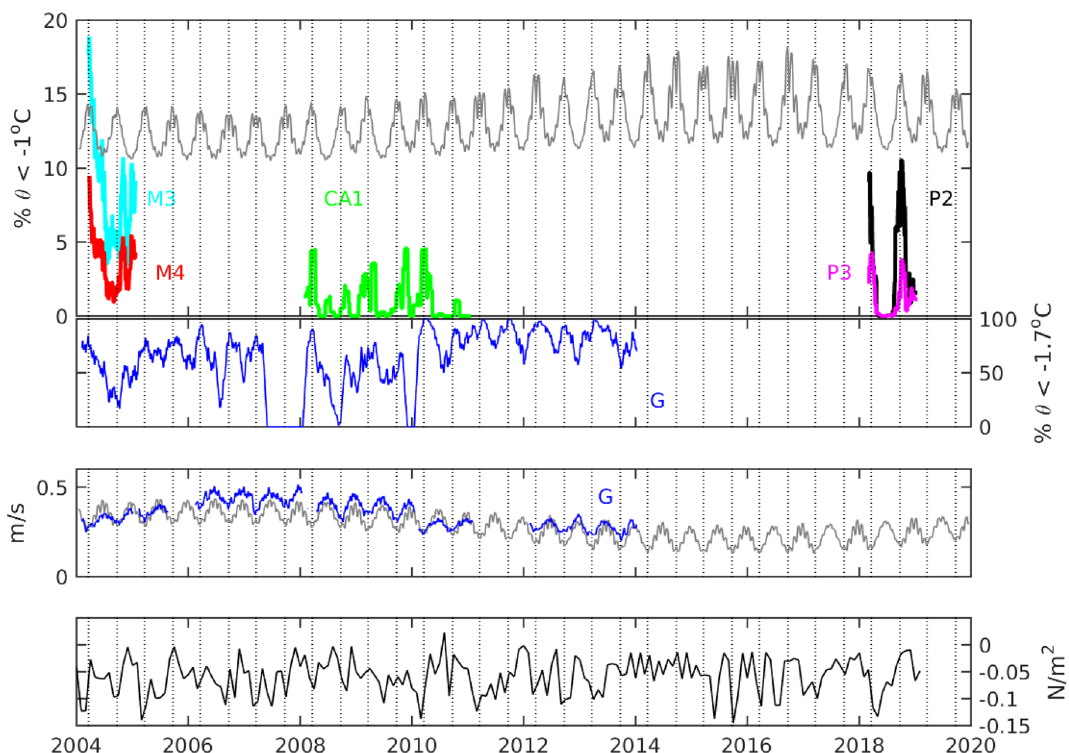
Figure 5. The upper panel shows the percentage of time water less than − 1 °C was measured at the bottom sensor of each mooring every month. The gray line is |u eq | −1 with arbitrary offset and scaling. The second panel shows the percentage of time water less than − 1.7 °C was measured at the bottom sensor of Mooring G in the Drygalski Trough. The third panel shows the magnitude of the velocity, averaged over a month, at Mooring G with the gray line showing the magnitude of u eq averaged over a month shifted downward by 0.15 m/s. The bottom panel shows the along-slope wind stress in the central Ross Sea, where negative values indicate a greater wind stress towards the west along the shelf. The vertical lines show the times of the